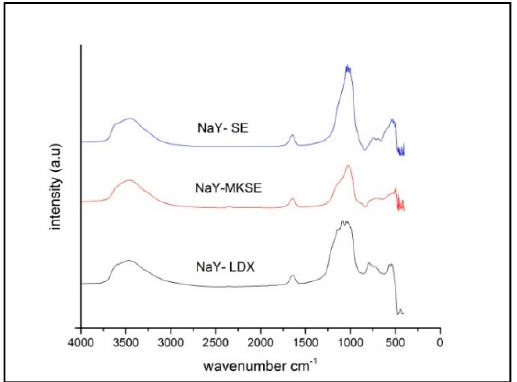
Figure 9. FTIR spectra of as-synthesized NaY zeolites from natural and synthetic precursor materials: NaY-SE ( top ), NaY-MKSE ( middle ) and NaY-LDX ( bottom ).